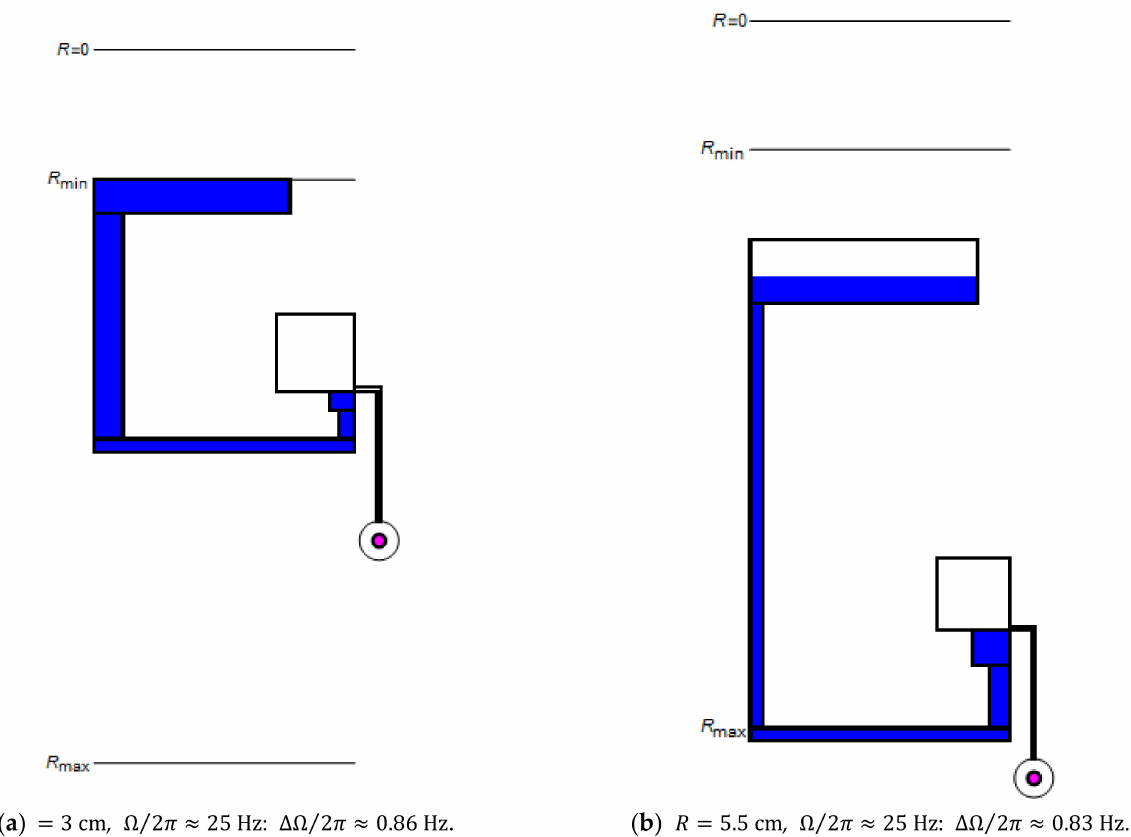
Figure 5. Minimization of the standard deviation ∆Ω for a set of CP-DF siphon valves Γ possessing equal retention rates Ω /2 π = 25 Hz, which are placed the radial positions ( a ) R = 3 cm and ( b ) R = 5.5